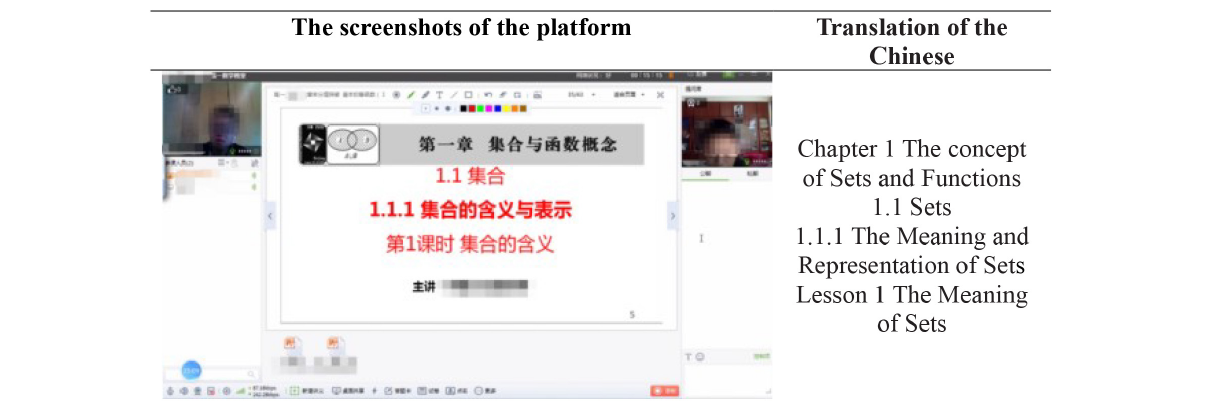
episodes between the teacher and the student into three types: (a) teacher-led, (b) student-led, and (c) alternating-led. The examples belonging to each type were distracted from four- sample tutoring sessions. In the teacher-led CPS, the